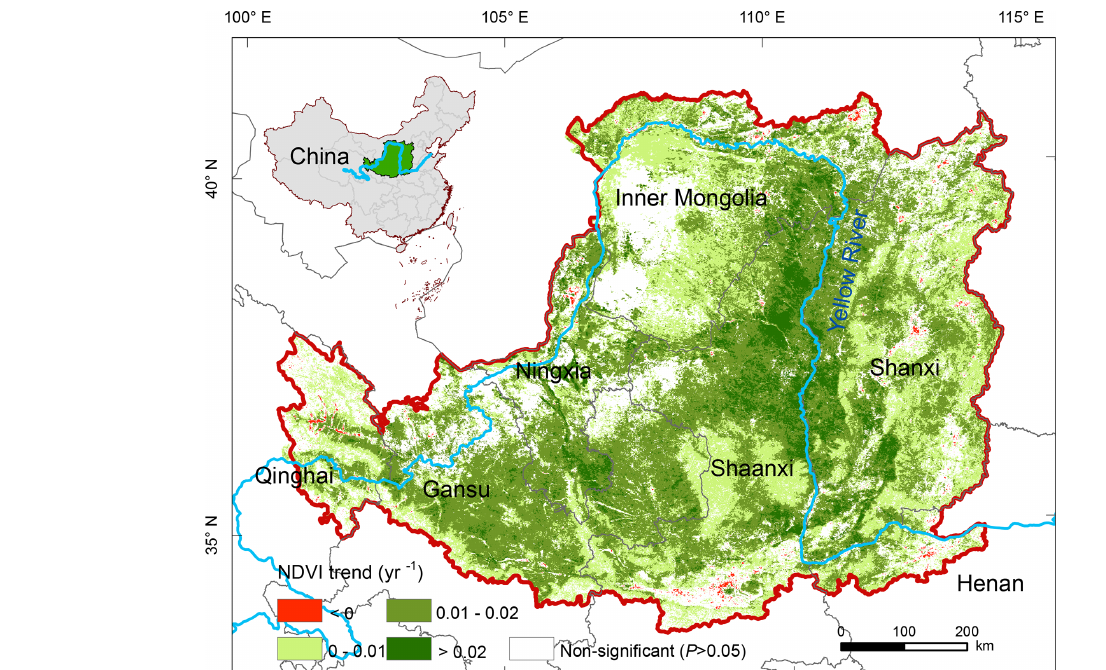
Figure 2. Location of the Loess Plateau and its normalized difference vegetation index (NDVI) trend from 2000 to 2015. Table 1. Regional characteristics of the LP (Fu et al., 2017; He et al.,